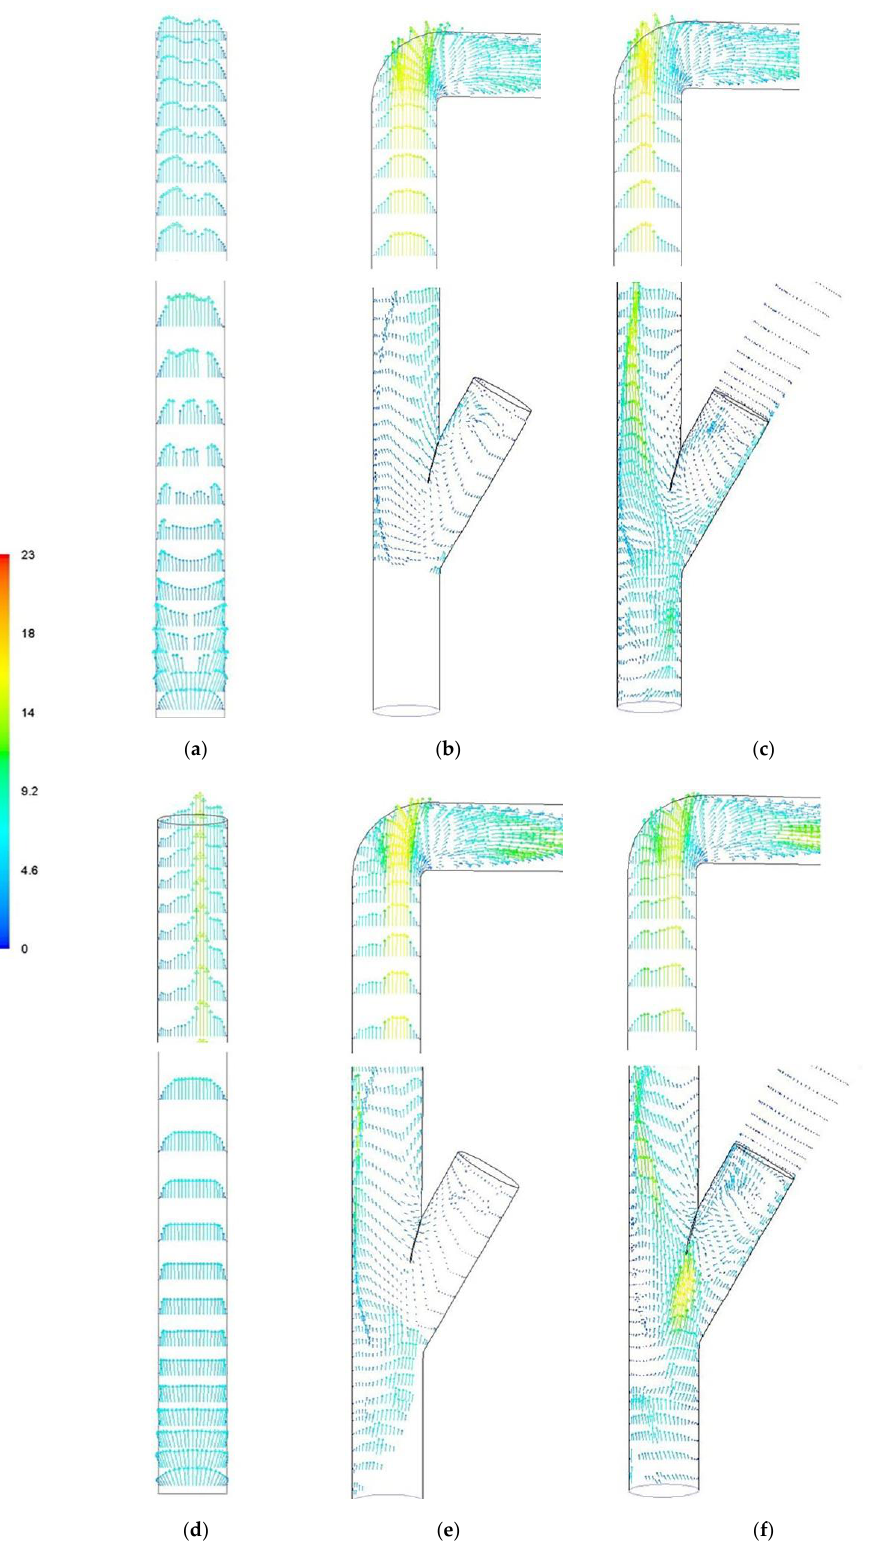
Figure 12. Comparison of solids velocity in the CFB between two methods. (a) Riser-simplified simulation in U g = 7 m s − 1 , G s = 50 kg m − 2 s − 1 ; (b) riser-only simulation in U g = 7 m s − 1 , G s = 50 kg m − 2 s − 1 ; ( c ) full-loop simulation in U g = 7 m s − 1 , G s = 50 kg m − 2 s − 1 ; ( d ) riser-simplified simulation in U g = 7 m s − 1 , G s = 300 kg m − 2 s − 1 ; ( e ) riser-only simulation in U g = 7 m s − 1 , G s = 300 kg m − 2 s − 1 ; ( f ) full-loop simulation in U g = 7 m s − 1 , G s = 300 kg m − 2 s − 1